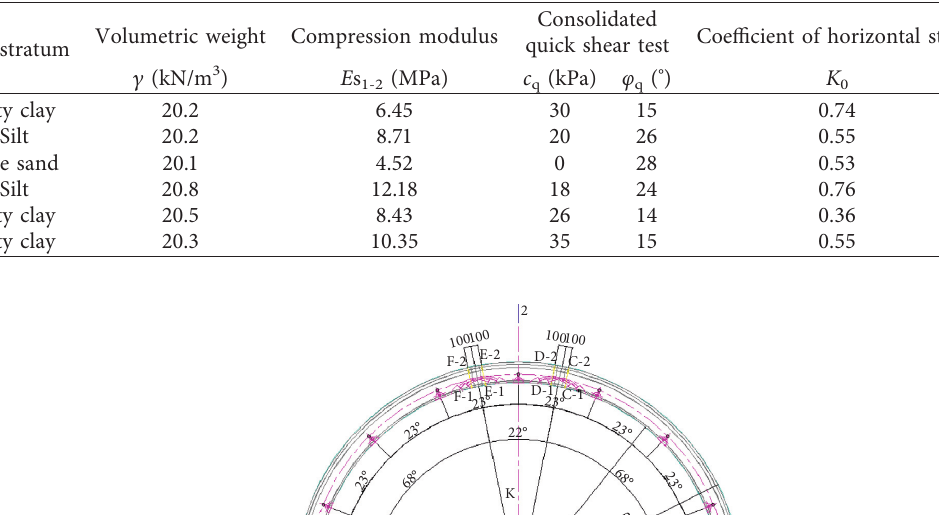
Table 1: Soil parameters.